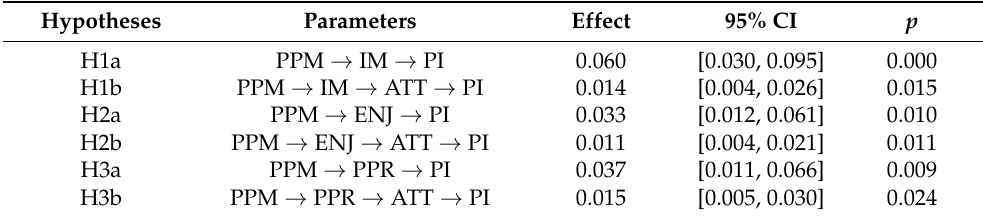
Table 3. Indirect effect of product presentation mode on patronage intention.